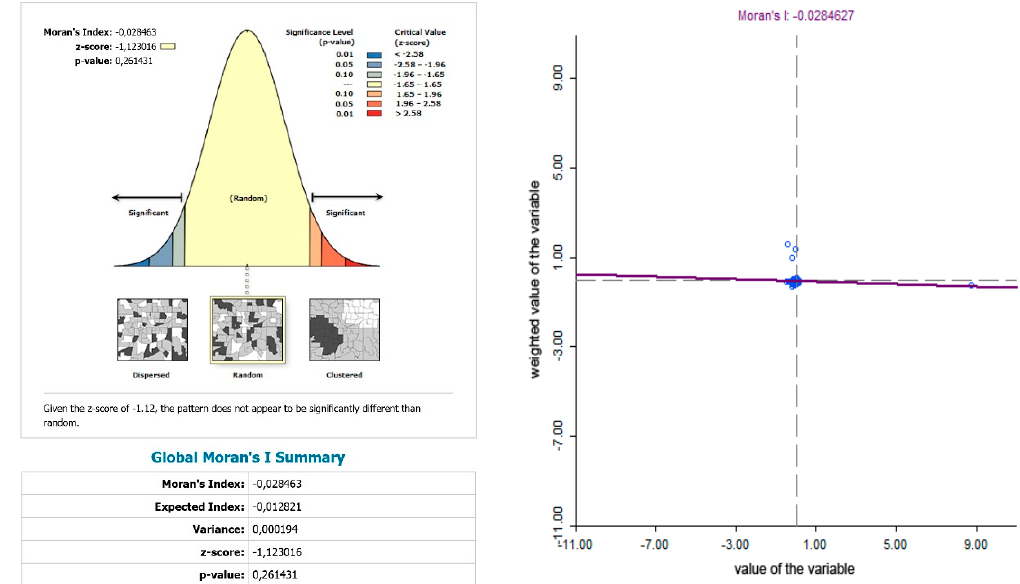
Figure 16 . Standardized death rate of prostate cancer per 1000 inhabitants of European Standard Population, 2013–2018. Source: Statistical Office of the Slovak Republic, 2019.